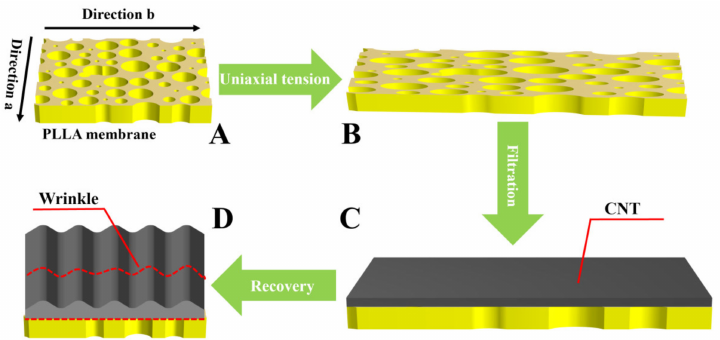
Scheme 1. Fabrication of CNT separation membranes with wrinkles based on shape memory effect of PLLA ( A ) via uniaxial tension ( B ), loading of CNTs ( C ) and formation of membranes ( D